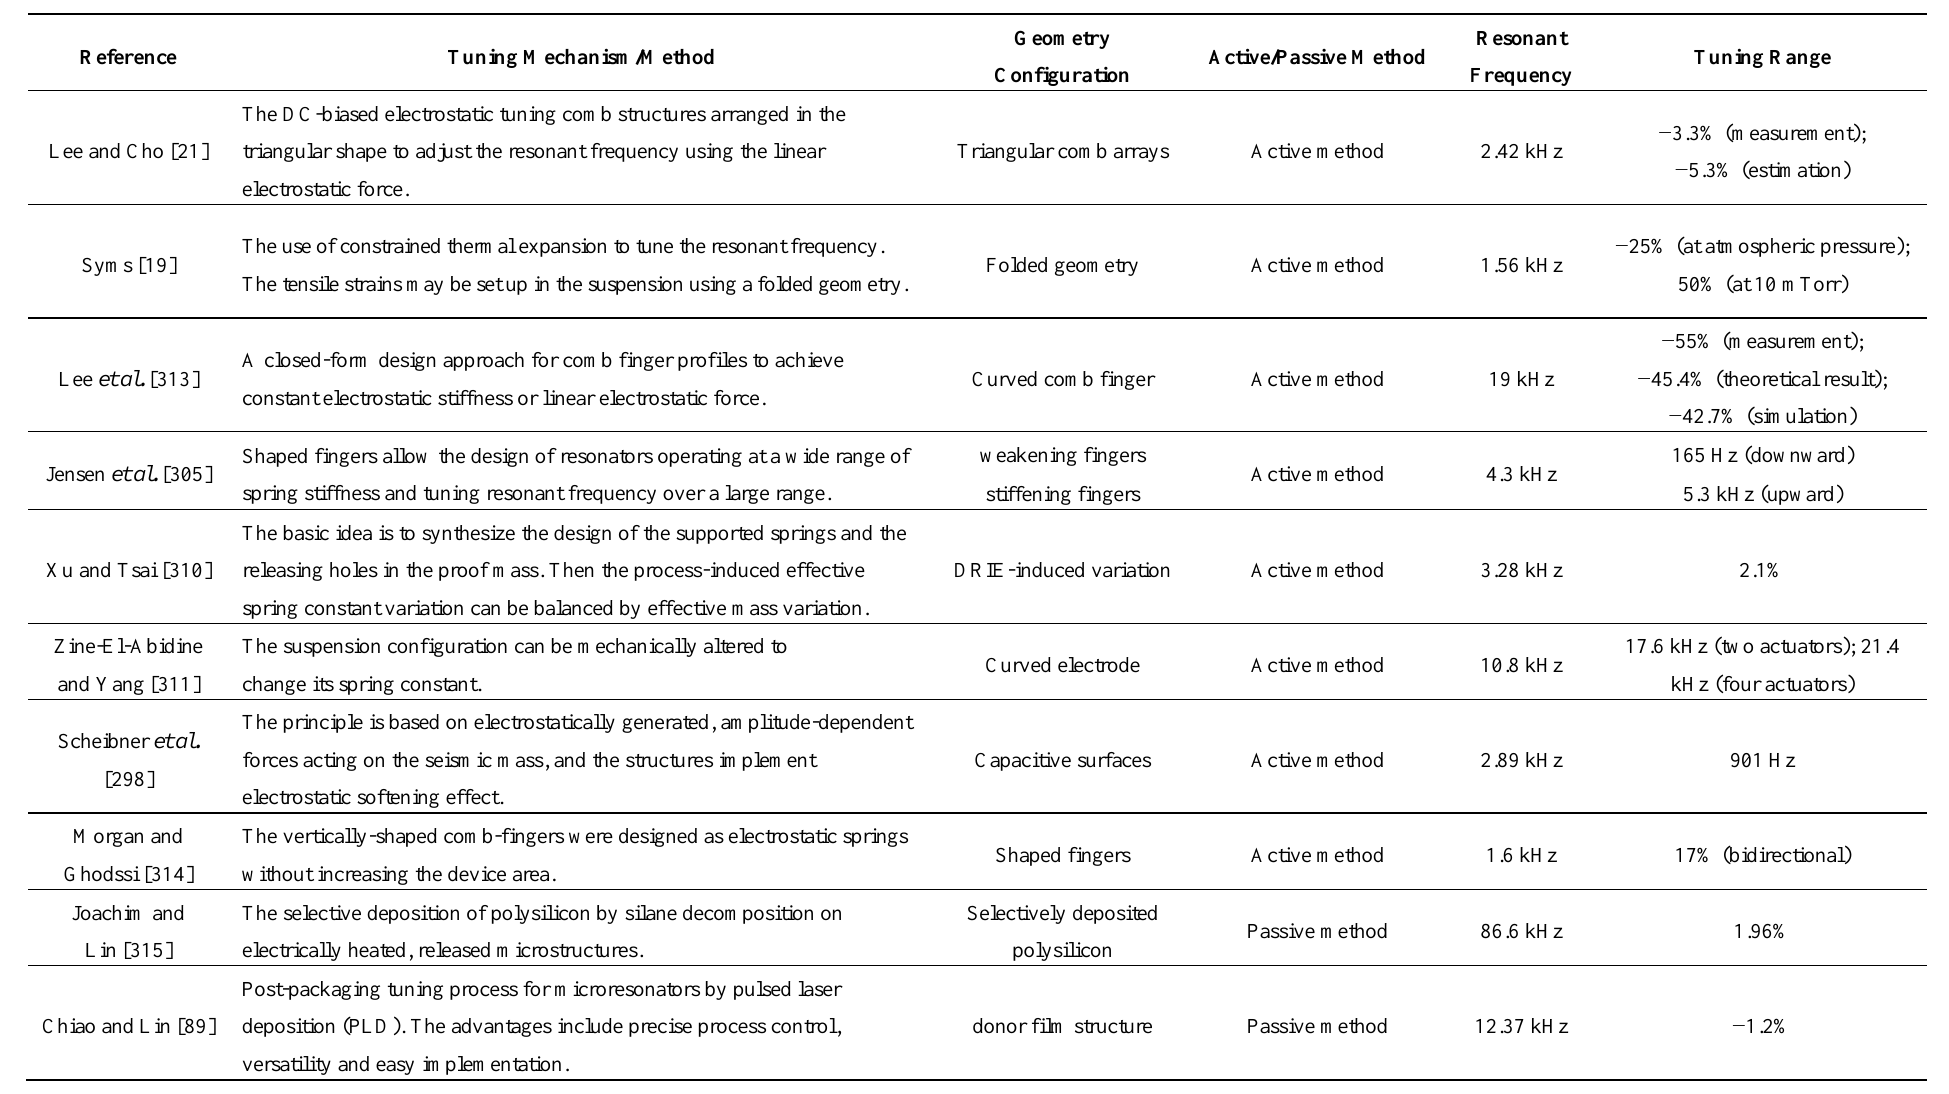
Table 8. Various frequency tuning methods for the comb-drive microresonators